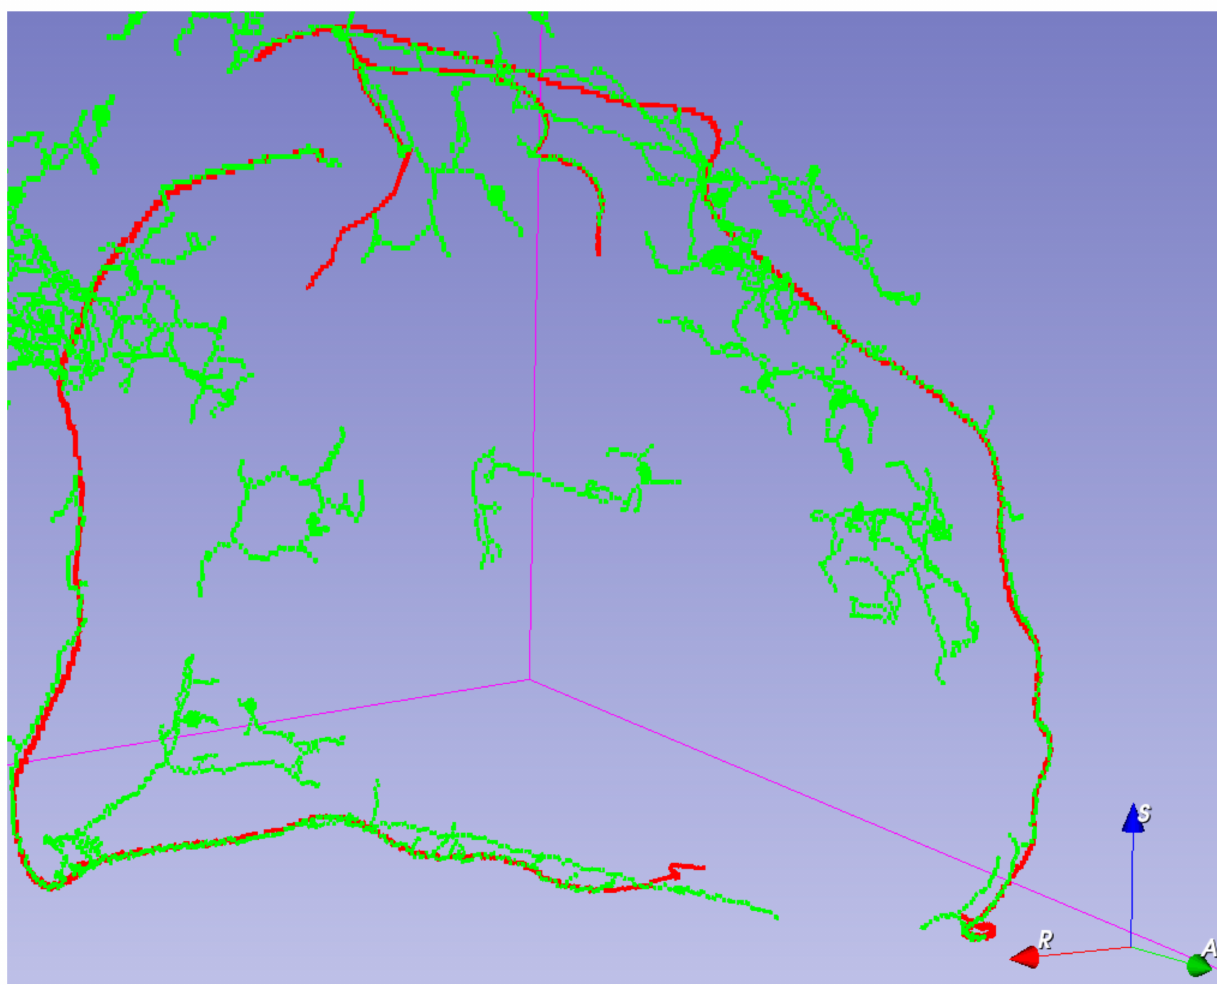
Figure 6. Patch size 256 × 256 × 128; a 3D Slicer rendering of ground truth (red) and centerline segmentation